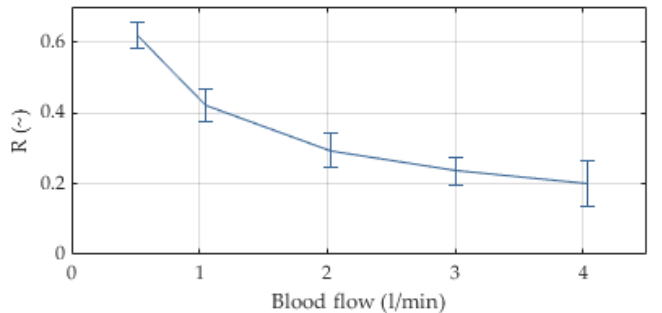
Figure 8. Heat transfer efficacy depicted as R-value (following the test protocol in ISO 7199), n = 10, mean and SD.